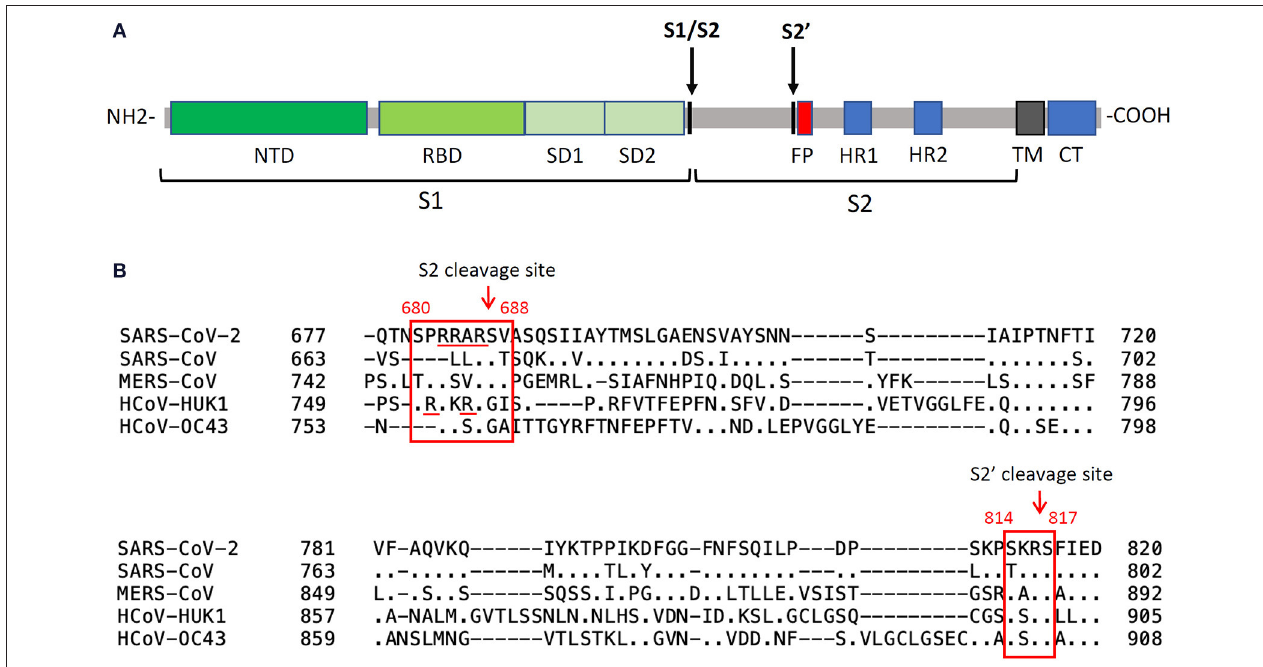
FIGURE 6 | Spike cleavage in betacoronaviruses. (A) schematic organization of the SARS-CoV-2 spike protein domains and cleavages by host proteases. The priming cleavage at the S2 site separates the subunit S1 from S2, while the activating cleavage occurs at the S2’ site in close proximity to the fusion peptide. NTD, N-terminal domain; RBD, receptor-binding domain; SD1, subdomain 1; SD2, subdomain 2; FP, fusion peptide; CH, central helix; SD3, subdomain 3; TM, transmembrane domain; CT, cytoplasmic tail. (B) sequence alignments of the regions containing the protease cleavage sites in human betacoronaviruses. The priming cleavage of SARS-CoV-2 involves a polybasic S2 furin cleavage sequence (RXXR) which is absent in other sarbecoviruses, such as in SARS-CoV, but is found in other human betacoronaviruses. Processing of S1/S2 exposes the S2’ site which can be cleaved by type II transmembrane serine protease and